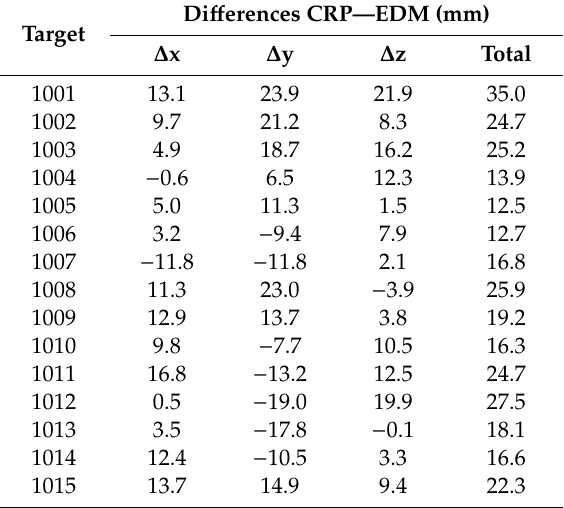
Table 2. Di ff erences between the close-range photogrammetry (CRP) and the EDM coordinates obtained for the check points.